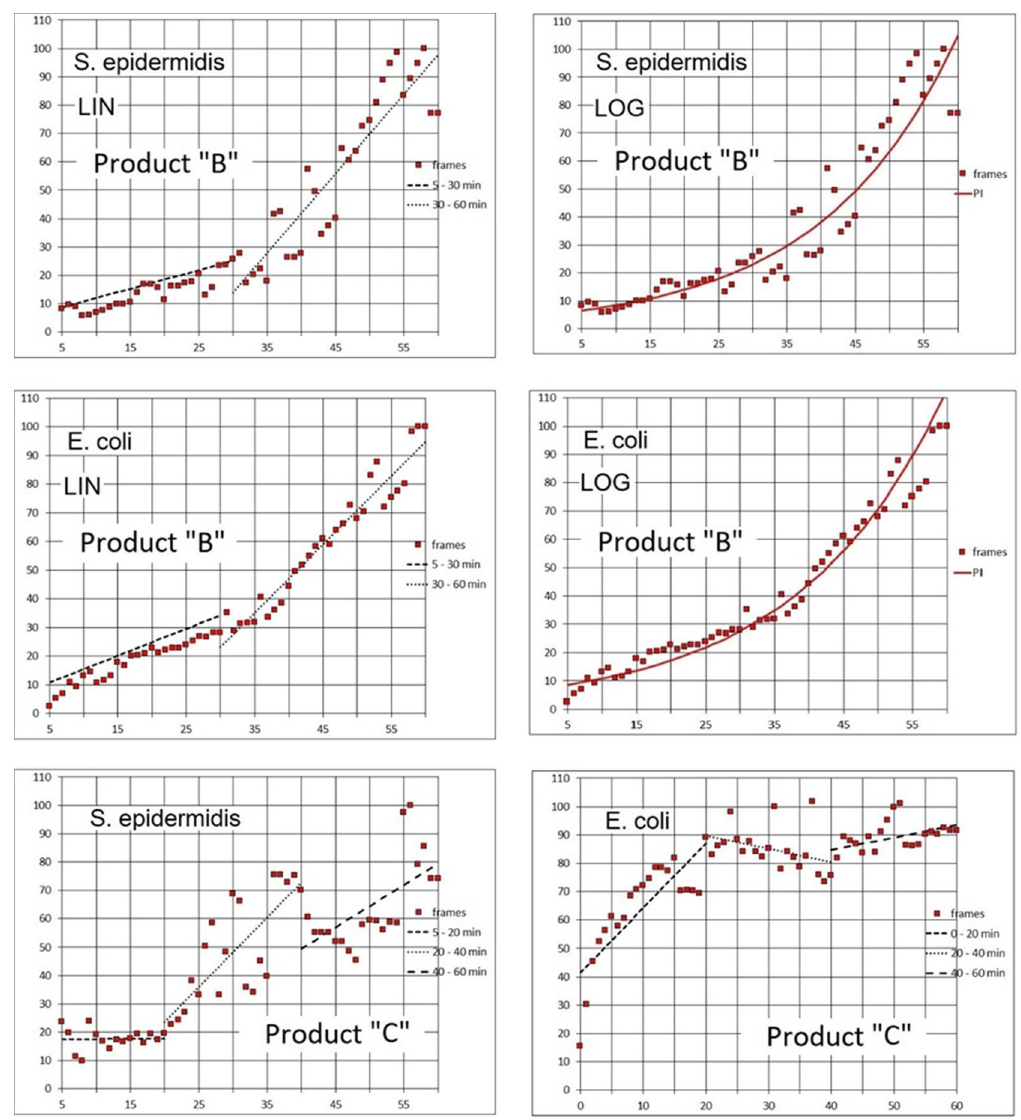
Figure 14. Product “B”: Time-lapse records of PI (red) fluorescence signal from a biofilm of S. epidermidis and E. coli exposed to Product “B”. Horizontal axis: time in minutes. Vertical axis: % of maximum frame luminance. LIN: Linear best fit for two intervals (25 and 30 min) after the delivery of product. LOG: Exponential best fit for the entire 1-h time series after the delivery of product. Same data set used for both LIN and LOG fit calculation.